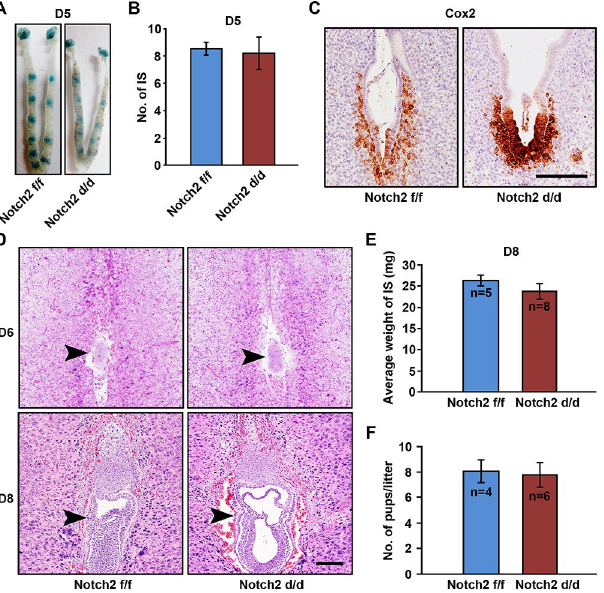
Fig 2. Uterine Notch2 deficiency did not affect implantation, decidualization and fertility. (A) Implantation sites were visualized by intravenous injection of blue dye on day 5 in Notch2 f/f and Notch2 d/d mice. (B) The number of implantation sites on day 5 was comparable between Notch2 f/f and Notch2 d/d mice. IS, implantation sites. (C) Embryo attachment was detected on day 5 in Notch2 f/f and Notch2 d/d mice by immunohistochemistry staining for Cox2. Scale bar: 50 μ m. (D) H&E staining displayed normal embryo development on day 6 and 8 in Notch2 f/f and Notch2 d/d females. Arrowheads indicate the embryo. Scale bar: 50 μ m. (E) The average weight of implantation sites was measured on day 8 in Notch2 f/f and Notch2 d/d groups. (F) The litter size was compared between Notch2 f/f and Notch2 d/d females. Data in (B), (E) and (F) are presented as mean ±